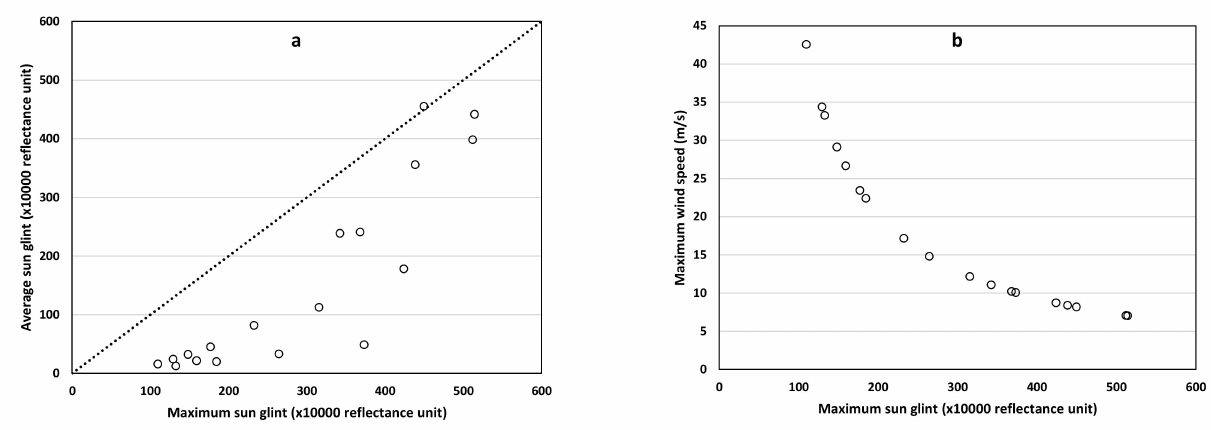
Figure 4. The relationship between maximum sun glint and average sun glint ( a ) and its corresponding wind speed ( b ) for 18 LJCO